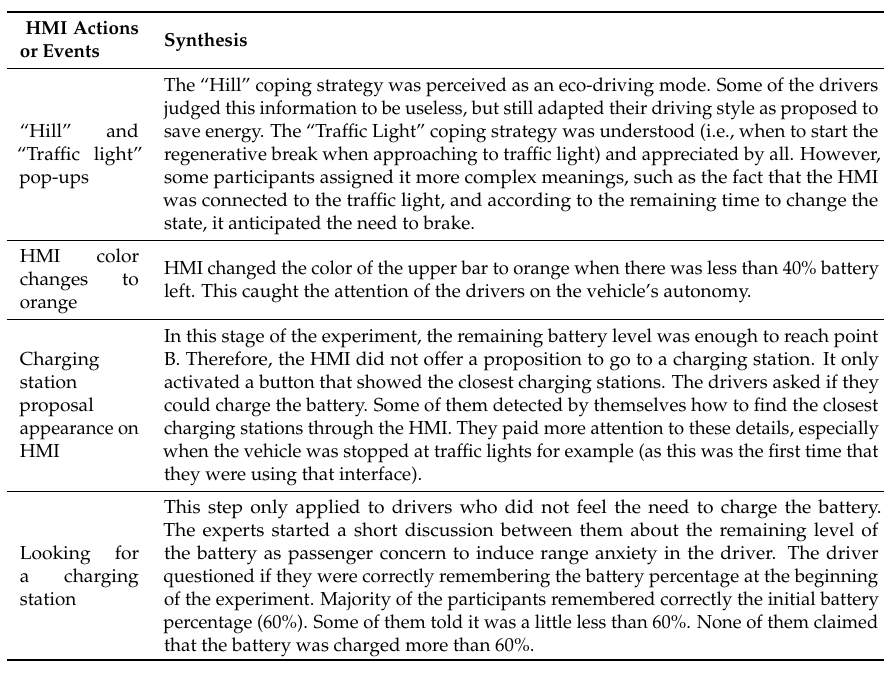
Table 2. Synthesis in terms of user experience per event and HMI actions taken in Scenario B. Further details and more verbatims from this scenario are available in Appendix